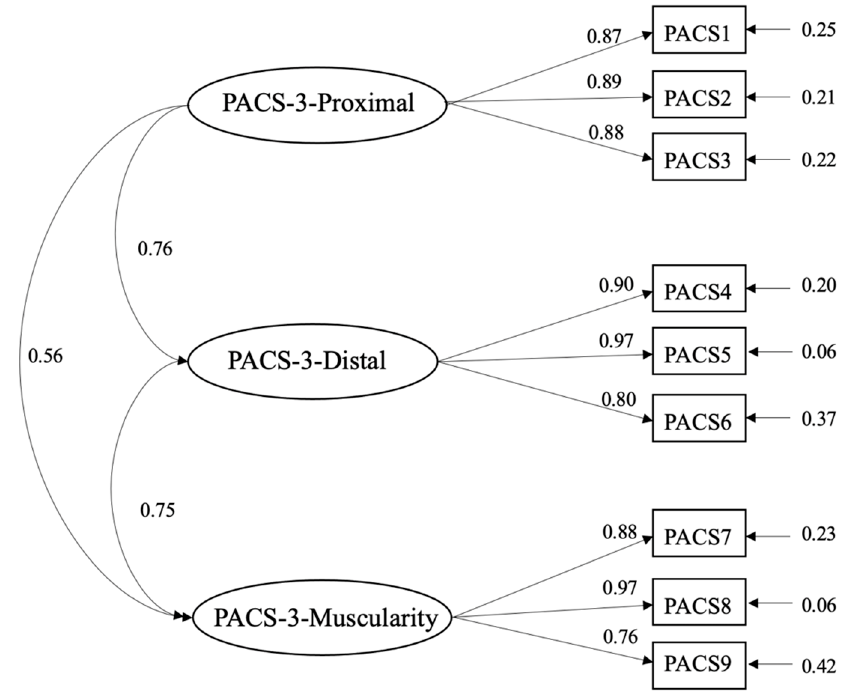
Figure 2. Path diagram and factor loadings of the Physical Appearance Comparison Scale–3 (PACS-3).